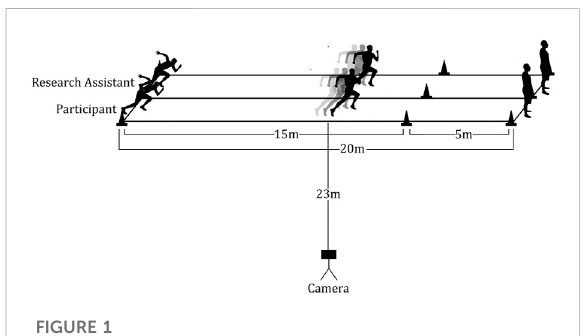
FIGURE 1 Illustration of The Course Design. *Each participant performed 2 trials × 20 m walking, jogging, and running. *5 m is a deceleration zone for the running course.